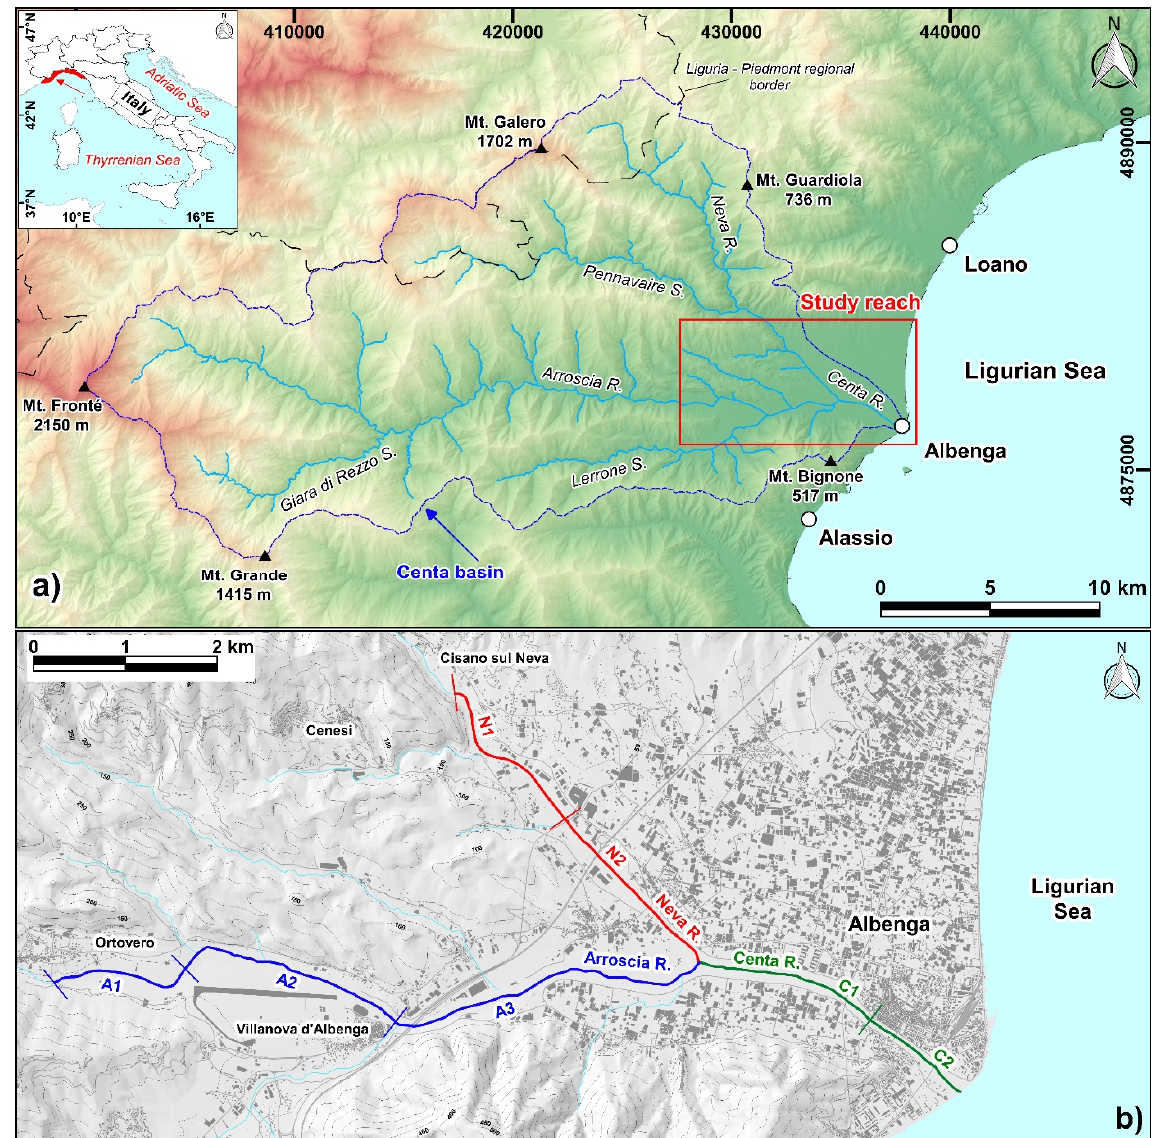
Figure 1. Location of the study reach. ( a ) The Centa River catchment. The Liguria Region is depicted in red; the red arrow indicates the Centa catchment location. ( b ) The investigated reaches of the Arroscia, Neva and Centa rivers.